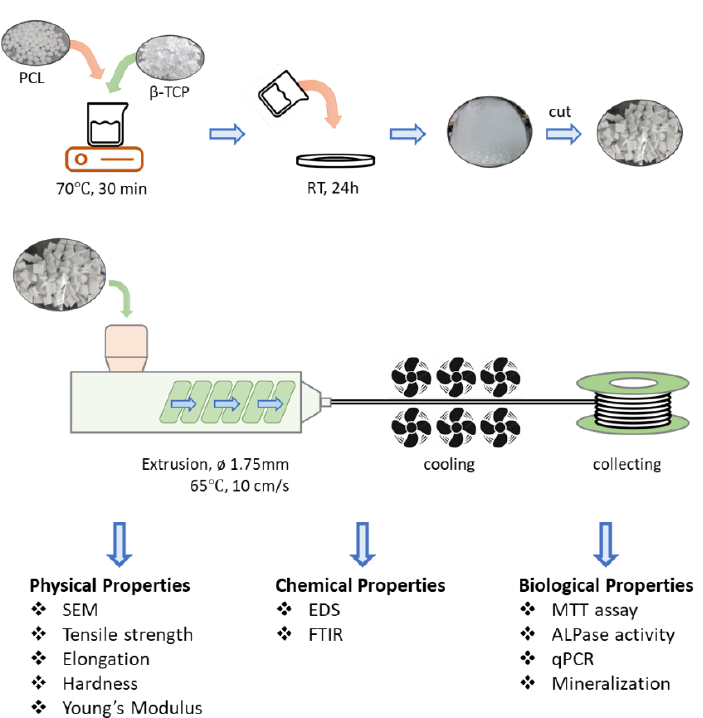
Figure 1. Solvent-free PCL/ β -TCP fiber manufacturing process. Different weight ratios of β -TCP were blended into melted PCL at 70 ± 5 °C for 30 min. Evenly mixed PCL/ β -TCP was poured onto a plate, spread into a thin layer, and cooled for 24 h at room temperature (RT). The sheet was granulated into small pieces and extruded into 1.75 ± 0.10 mm diameter fibers.